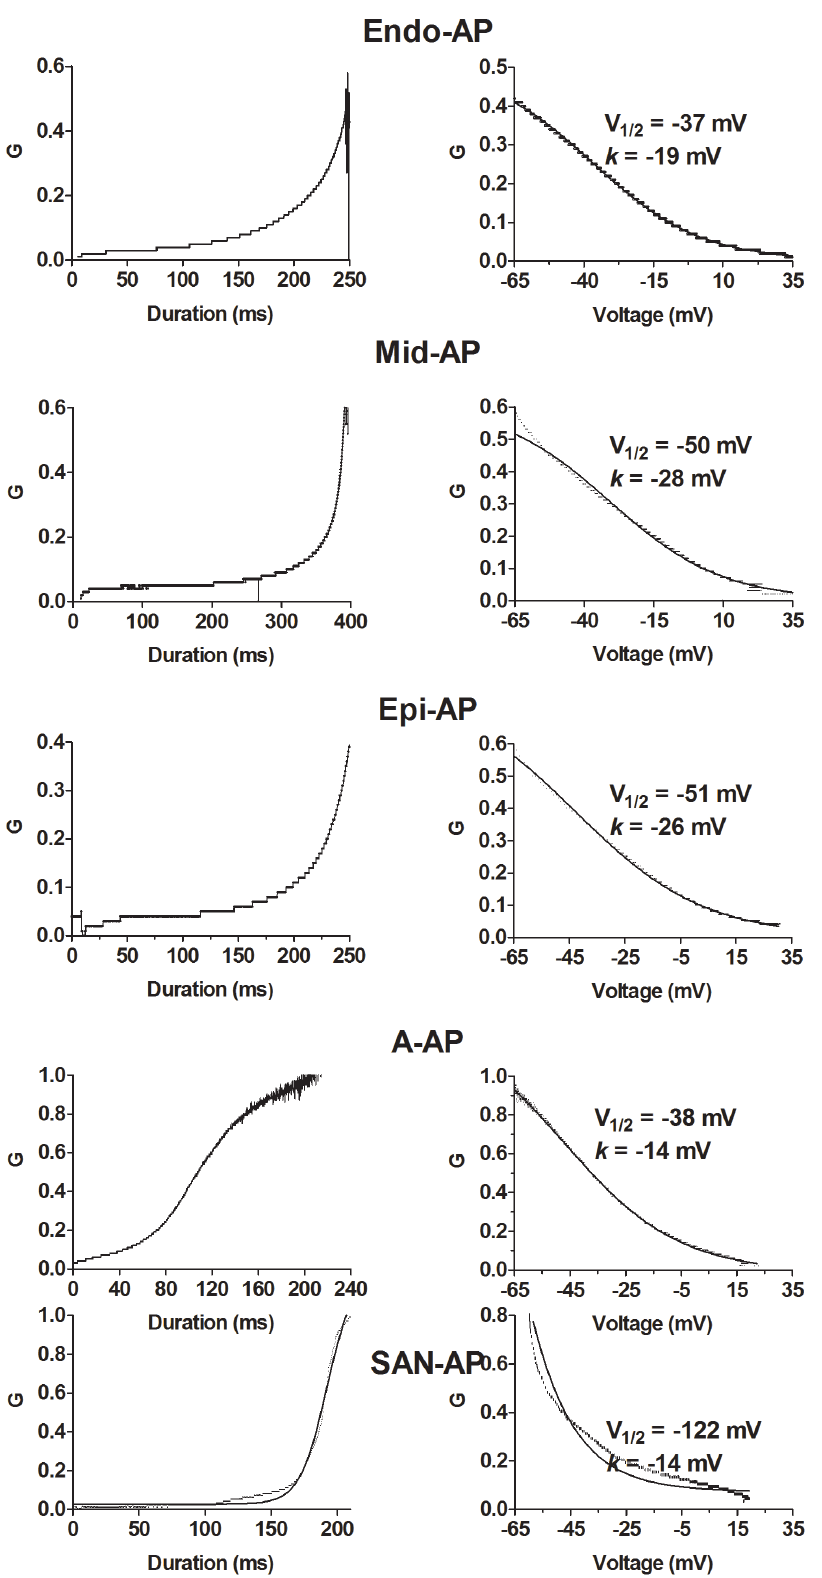
Figure 5. Time- and voltage-dependence of the instantaneous conductance of HERG K + channels reported by AP-clamp. The instantaneous conductance (G) was calculated by dividing the current amplitude by the membrane potential of an AP. Left panels: G as a function of time (APD); Right panel: G as a function of membrane potential. The latter is considered as instantaneous inactivation. The lines represent the Boltzmann fit to the experimental data points. doi:10.1371/journal.pone.0072181.g005 PLOS ONE |